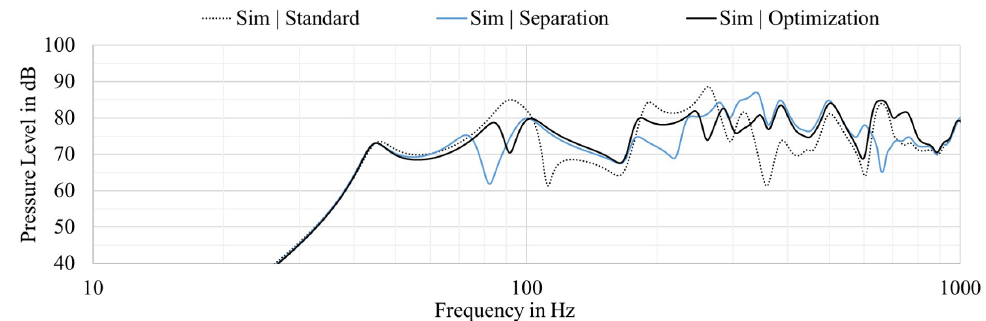
Figure 18. Comparison of the simulation results of the standard version, the separation ( r = 0.07 m, t = 0.01 m) and the optimized version ( r = 0.12 m, t = 0.012